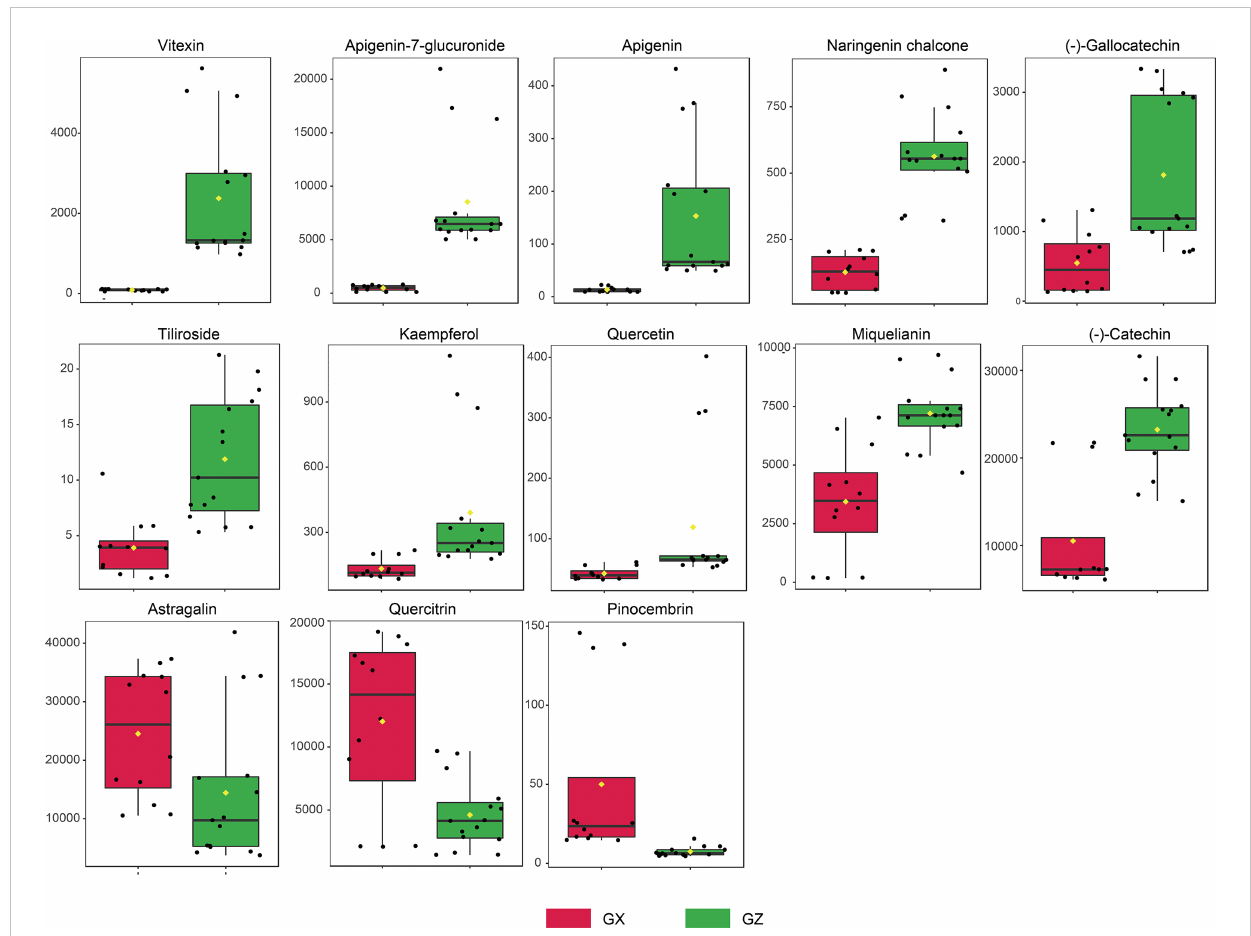
FIGURE 4 Concentration variation of fl avonoid markers in P. petiolosa from different origins. Y-axis unit is